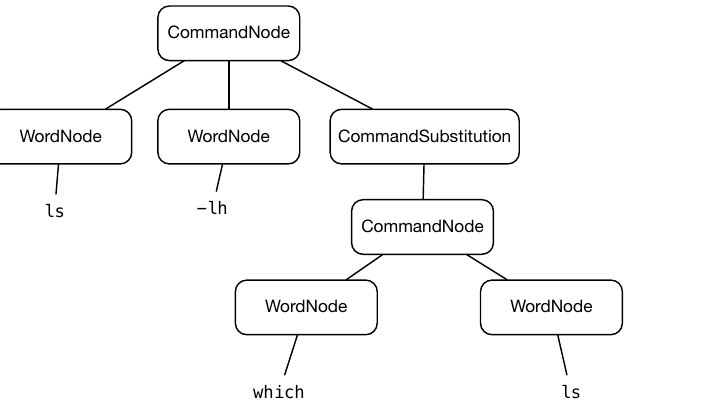
Figure 4. An AST represents a command ‘ ls -lh $(which ls) ’ that consists of a command substi- tution ‘ $(which ls) ’.